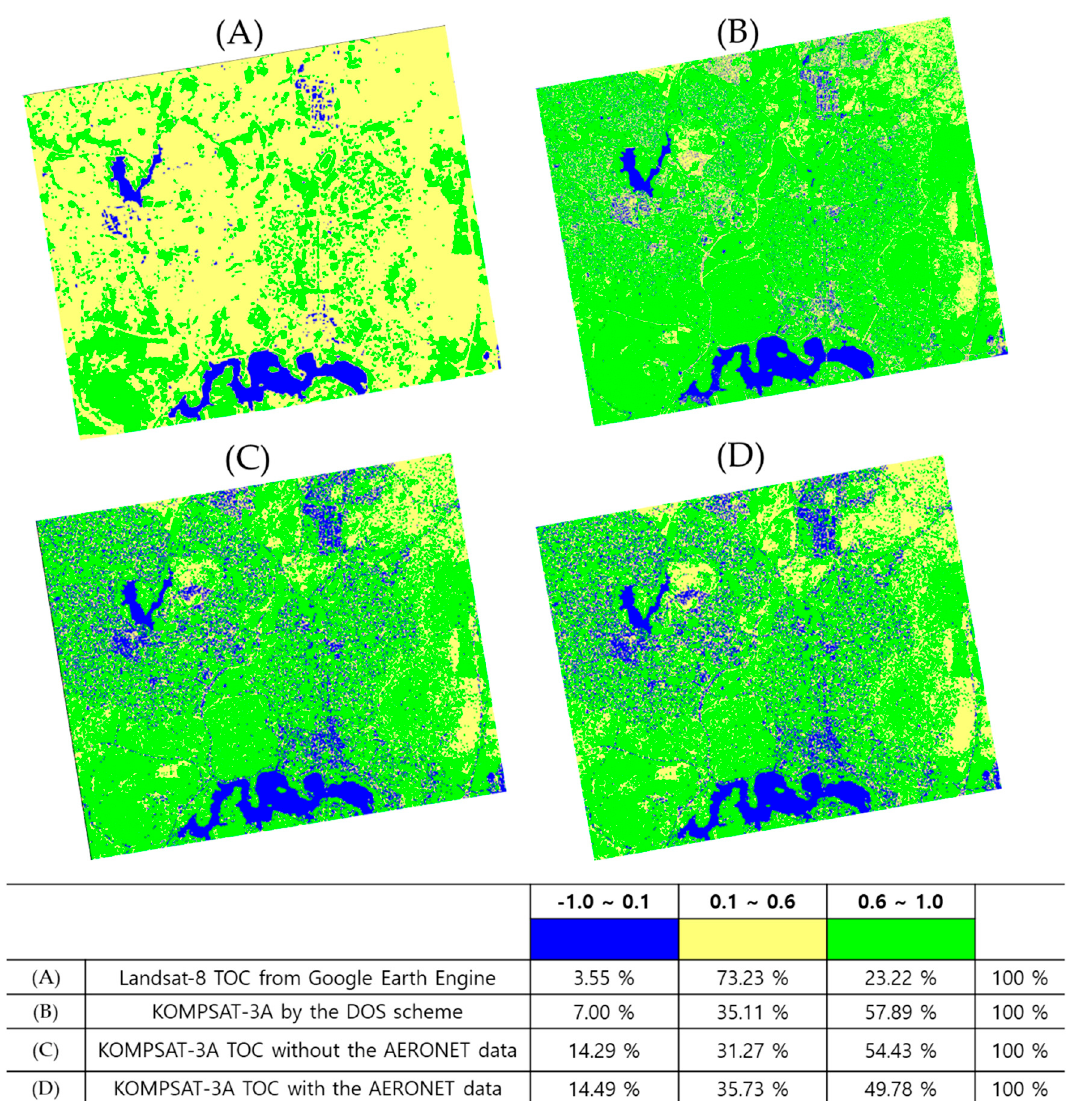
Figure 8. Comparison of the NDVI results of three classes by density slicing: ( A ) Landsat-8 surface reflectance tier 1 in the Google Earth Engine, ( B ) DOS-based reflectance, ( C ) TOC reflectance without the AERONET data, and ( D ) TOC reflectance with the AERONET